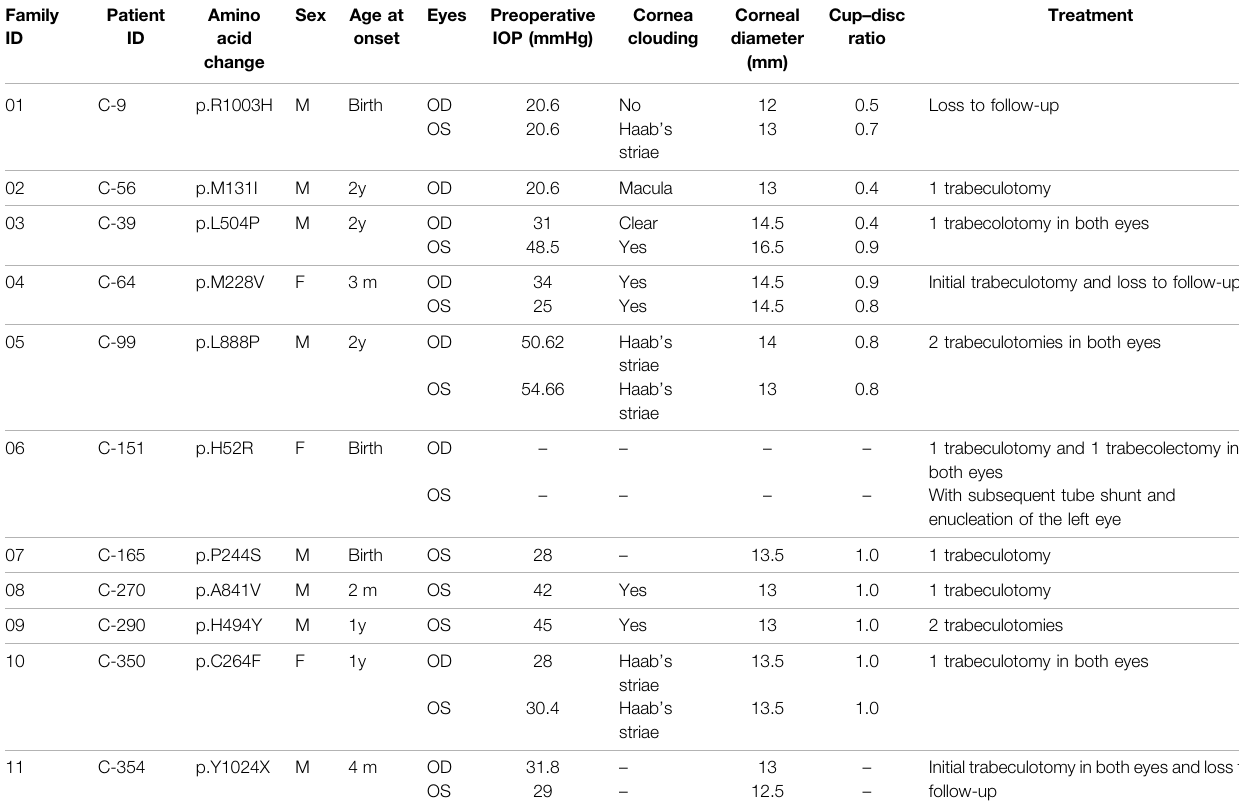
TABLE 3 | Clinical information for TEK-mutated patients.